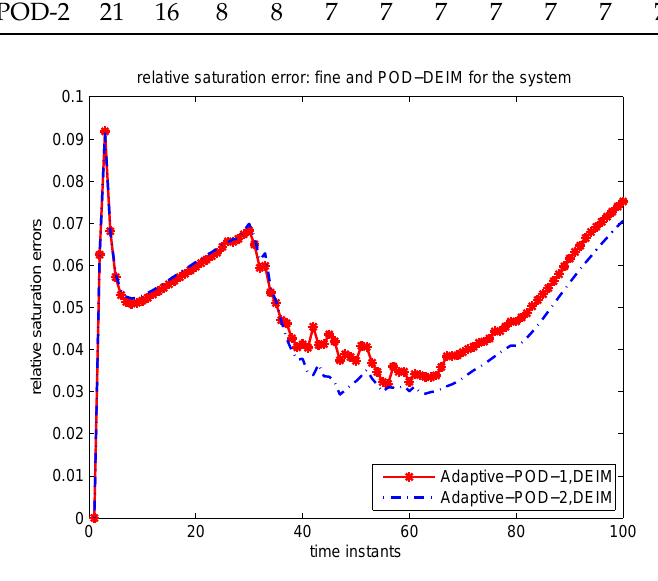
Figure 15. Relative saturation errors advancing in time: POD-DEIM for the coupled system.